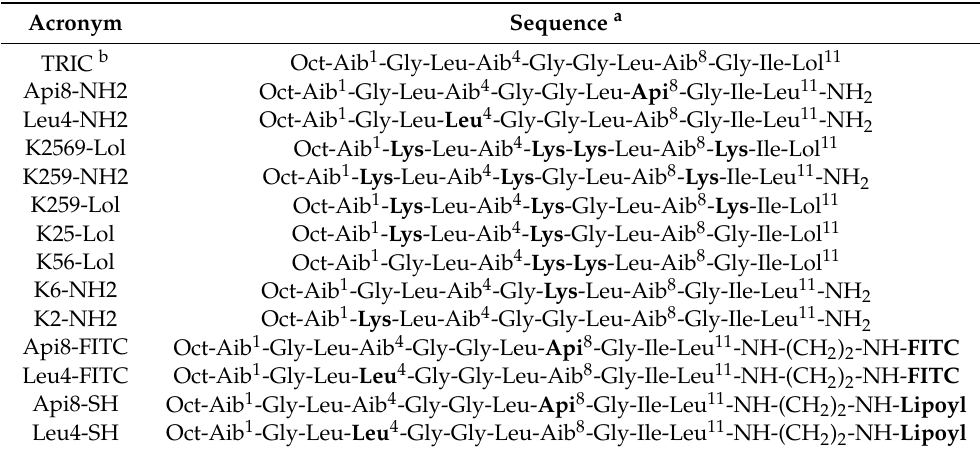
Table 1. Primary structure of the trichogin analogs studied in this